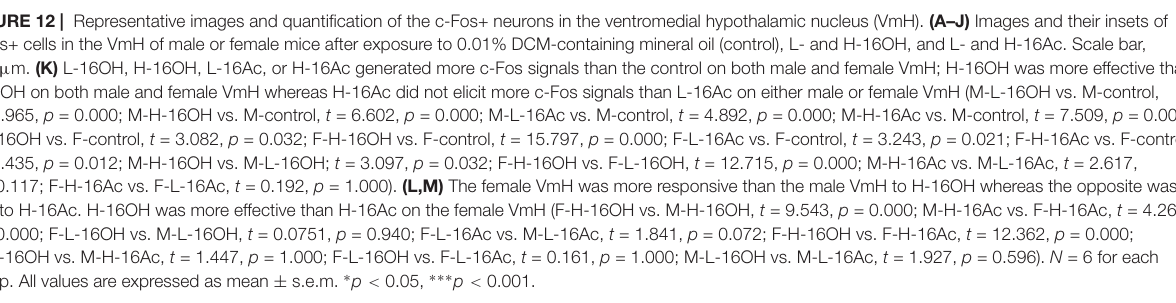
FIGURE 12 | Representative images and quantification of the c-Fos+ neurons in the ventromedial hypothalamic nucleus (VmH). (A–J) Images and their insets of c-Fos+ cells in the VmH of male or female mice after exposure to 0.01% DCM-containing mineral oil (control), L- and H-16OH, and L- and H-16Ac. Scale bar, 200 µ m. (K) L-16OH, H-16OH, L-16Ac, or H-16Ac generated more c-Fos signals than the control on both male and female VmH; H-16OH was more effective than L-16OH on both male and female VmH whereas H-16Ac did not elicit more c-Fos signals than L-16Ac on either male or female VmH (M-L-16OH vs. M-control, t = 2.965, p = 0.000; M-H-16OH vs. M-control, t = 6.602, p = 0.000; M-L-16Ac vs. M-control, t = 4.892, p = 0.000; M-H-16Ac vs. M-control, t = 7.509, p = 0.000; F-L-16OH vs. F-control, t = 3.082, p = 0.032; F-H-16OH vs. F-control, t = 15.797, p = 0.000; F-L-16Ac vs. F-control, t = 3.243, p = 0.021; F-H-16Ac vs. F-control, t = 3.435, p = 0.012; M-H-16OH vs. M-L-16OH; t = 3.097, p = 0.032; F-H-16OH vs. F-L-16OH, t = 12.715, p = 0.000; M-H-16Ac vs. M-L-16Ac, t = 2.617, p = 0.117; F-H-16Ac vs. F-L-16Ac, t = 0.192, p = 1.000). (L,M) The female VmH was more responsive than the male VmH to H-16OH whereas the opposite